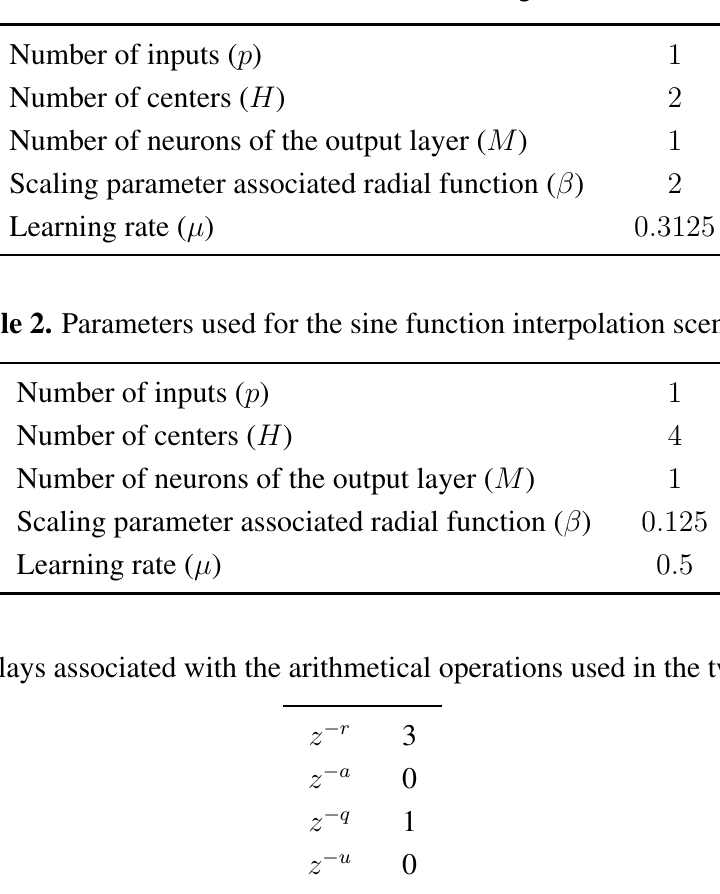
Table 1. Parameters used for the XOR gate scenario.